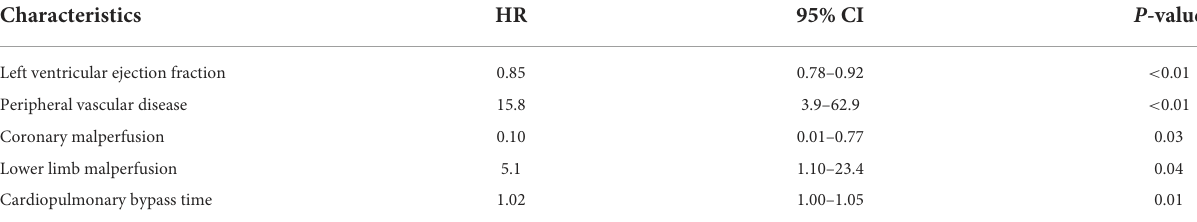
TABLE 4 Multiple Cox PH model for long-term survival.